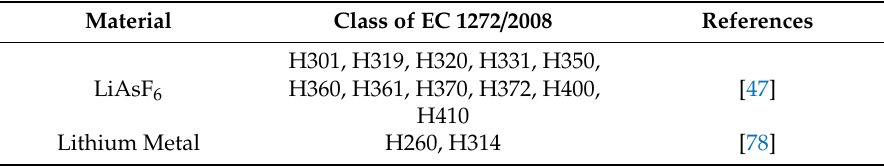
Table 3. Hazard statements of LiAsF 6 and lithium metal.